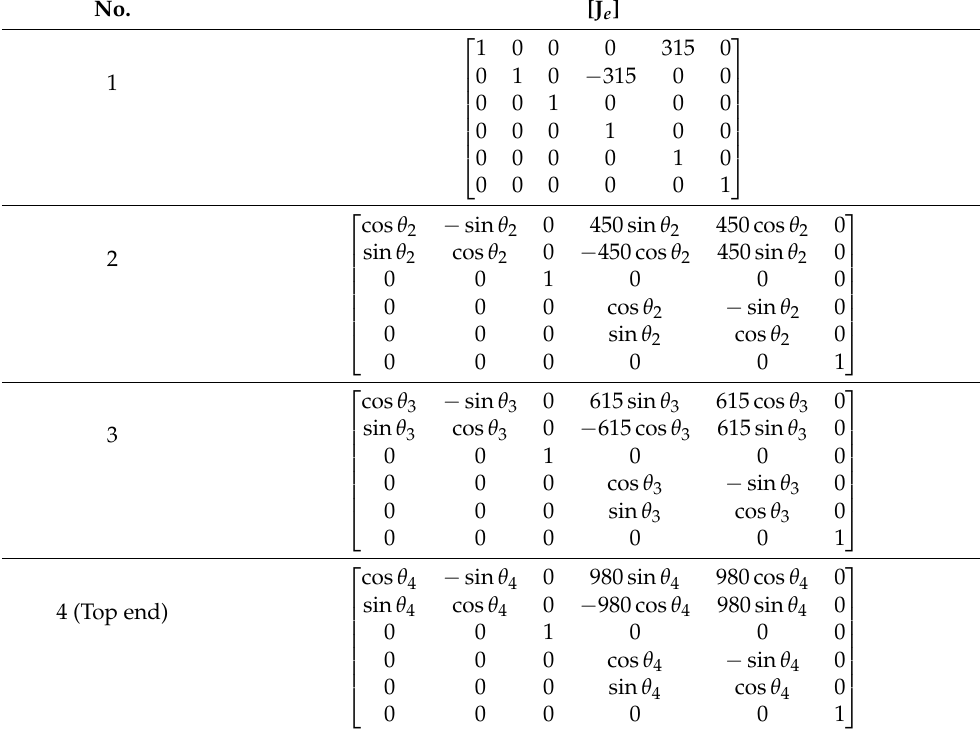
Table 5. Extended Jacobian